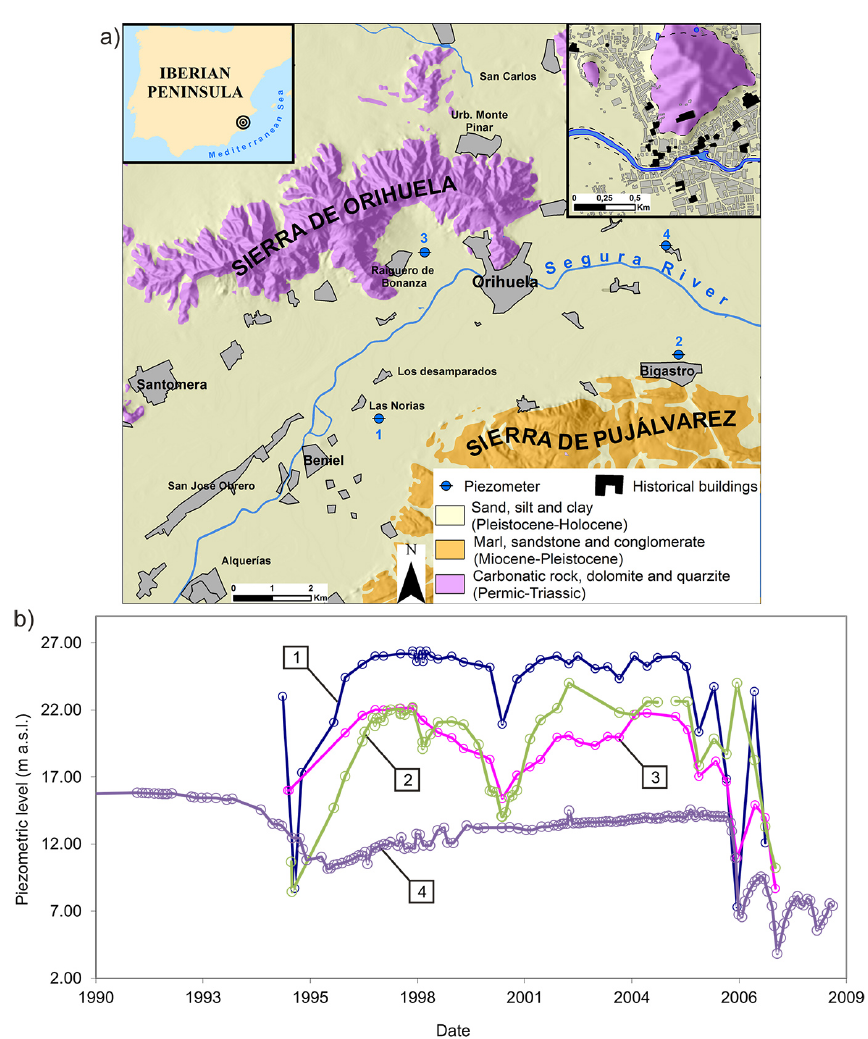
Figure 1. (a) Location and geology of the study area. (b) Piezometric level evolution for the study